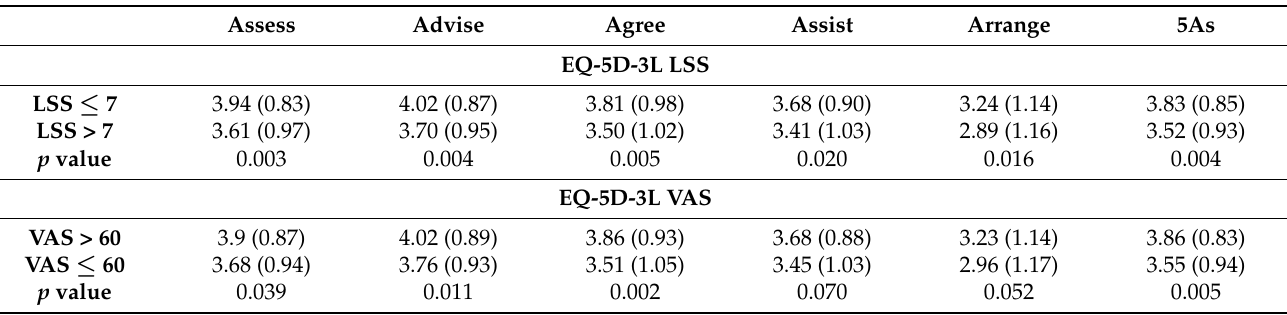
Table 5. The comparison of PACIC+ score according to the level of quality of life (EQ-5D-3L). Data are presented as mean (standard